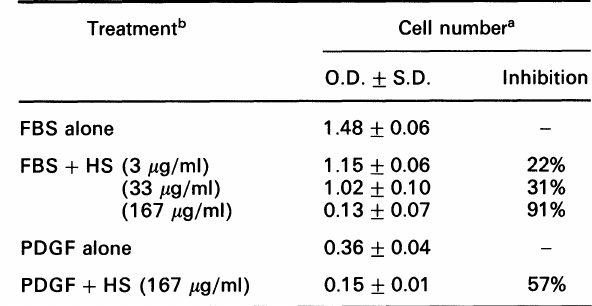
Table 3. Effect of pre-treatment of Nor-10 SMC with HS on proliferation induced by FBS or PDGF Treatment